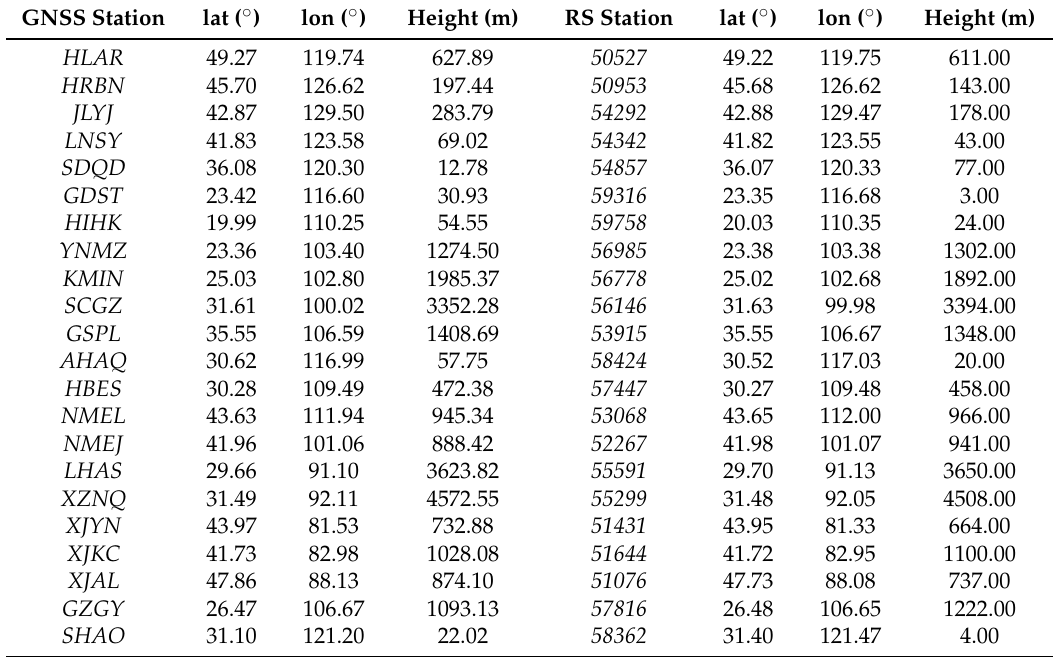
Table 3. Geodetic coordinates of RS sites and their nearby CMONOC GNSS